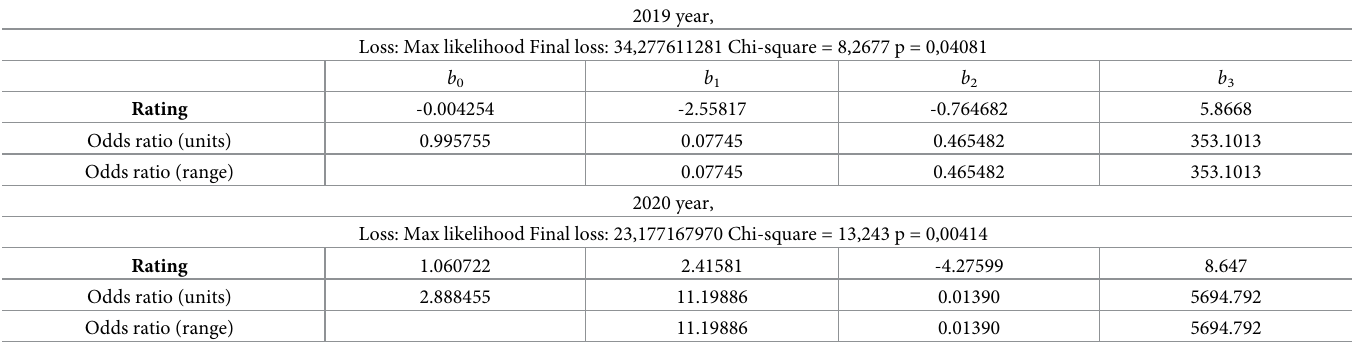
Table 8. Results of the logit model for assessing fluctuations in the economic, financial, budgetary and political-institutional development of countries as a result of the pandemic.